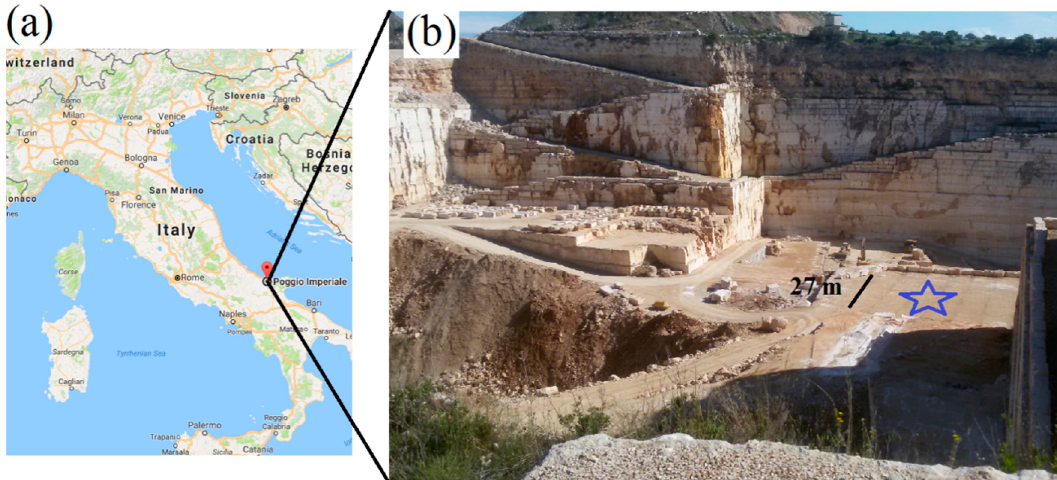
Figure 1. ( a ) A map of Italy showing the location of Poggio Imperiale (Google Maps), ( b ) A panoramic view of the quarry; the blue star refers to the surface of the bench under study.